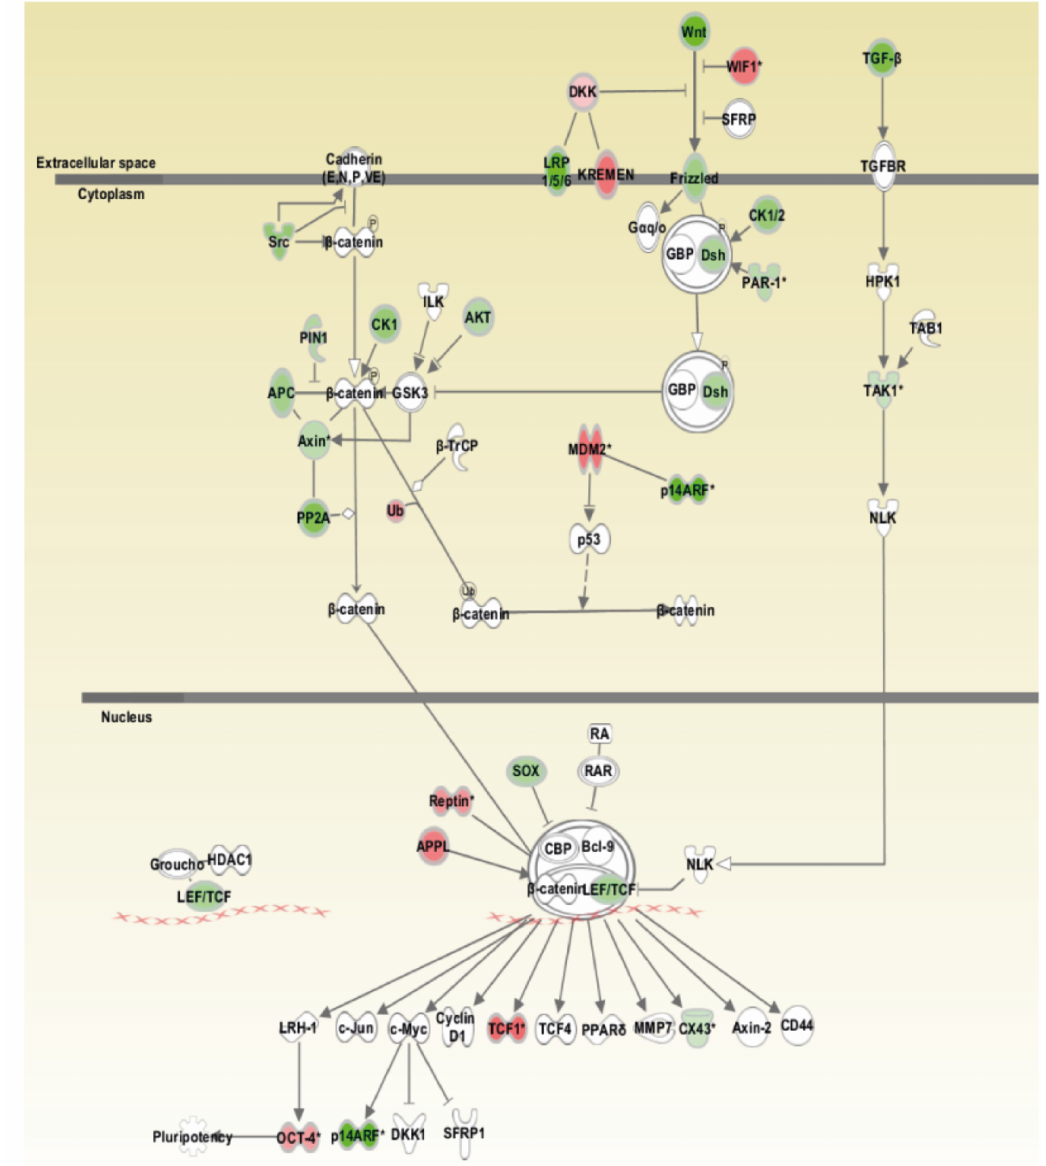
Figure 5. Wingless-type (WNT) signaling pathway. To investigate possible interactions of genes located in chromosomal regions with gains or losses, as determined by array-comparative genomic hybridization (CGH), ingenuity pathway analysis (IPA) has been performed. One of the most highly rated networks in IPA analysis was the WNT signaling pathway. The chromosomal regions coding for genes that are shaded were determined to be significant from the statistical analysis. The genes shaded red are located in chromosomal regions with gains and those that are green are located in chromosomal regions with losses. White shaded genes relate to the pathway but were not found to be altered in the actual analysis. The intensity of the shading shows to what degree an amplification or loss of the specific chromosomal region was detected. A solid line represents a direct interaction between the two gene products, arrows show activating interactions, bar-headed lines